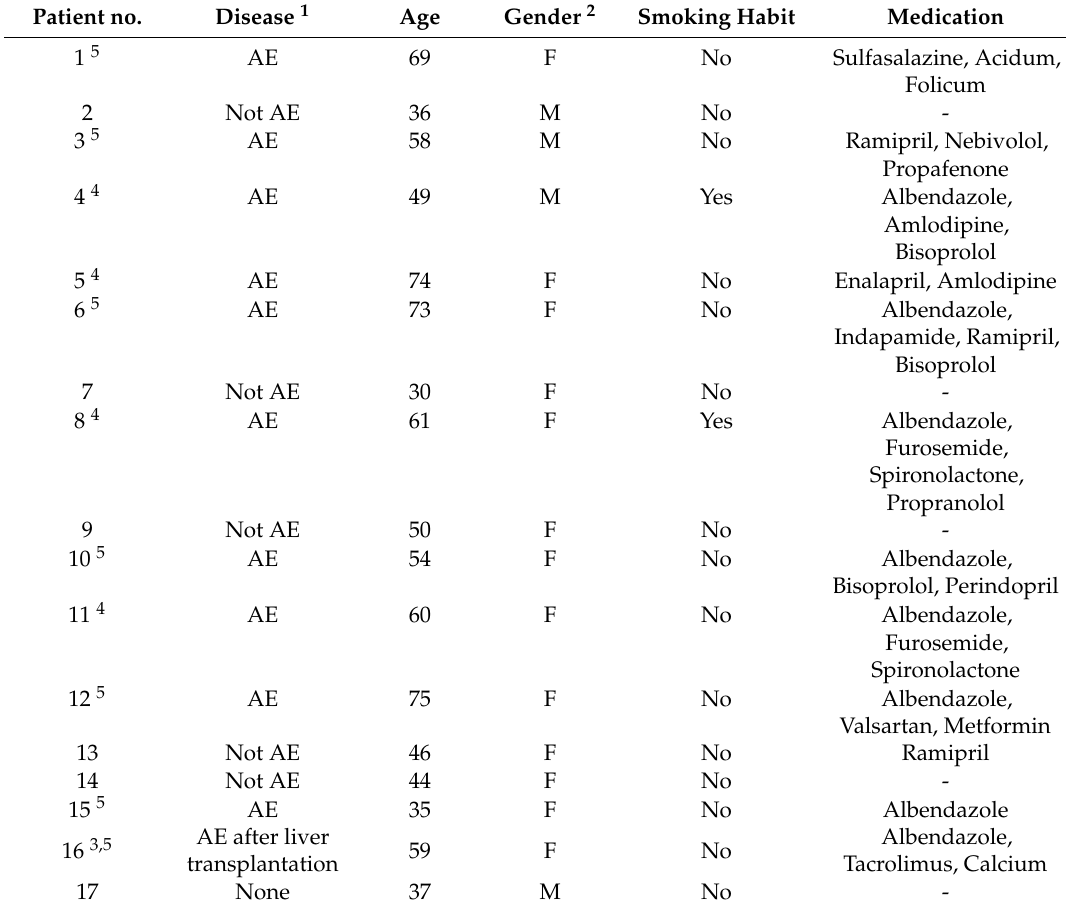
Table 1. Information about the volunteers included in the study. Patient